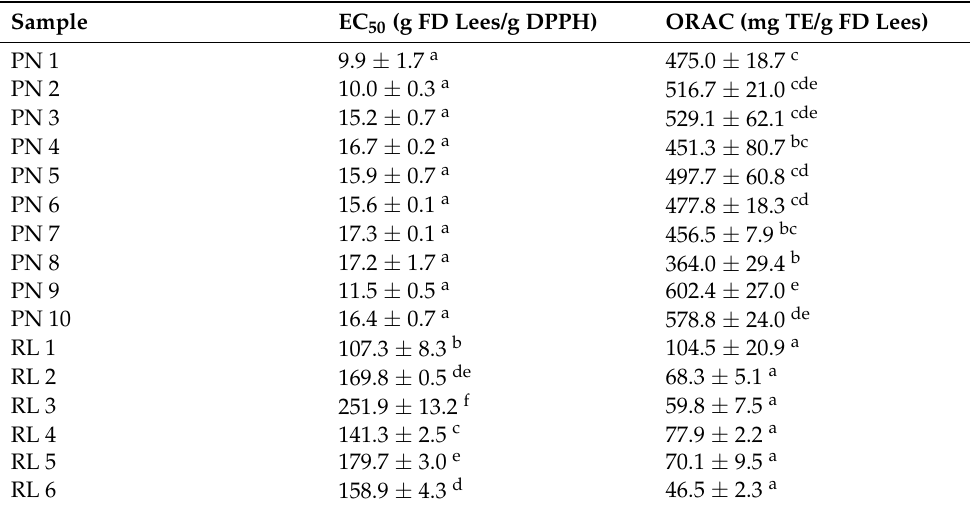
Table 3. Mean antioxidant activity of wine lees samples was measured by DPPH radical scavenging activity (EC 50 ) and oxygen radical absorbance capacity